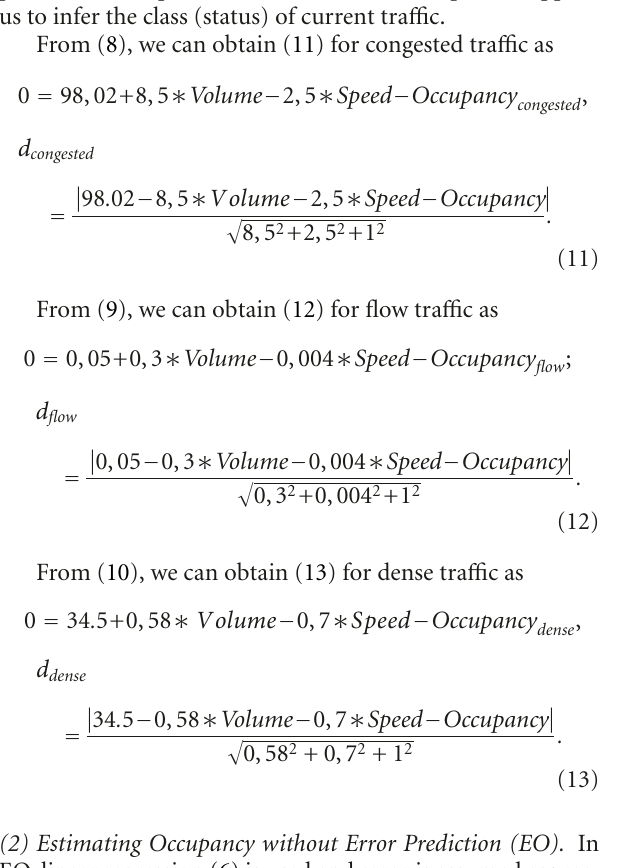
points and each plane. The result (i.e., nearest plane) supplies us to infer the class (status) of current tra ffi c.